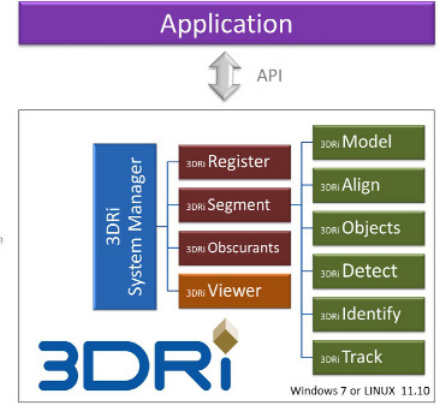
Figure 7: 3DRi software